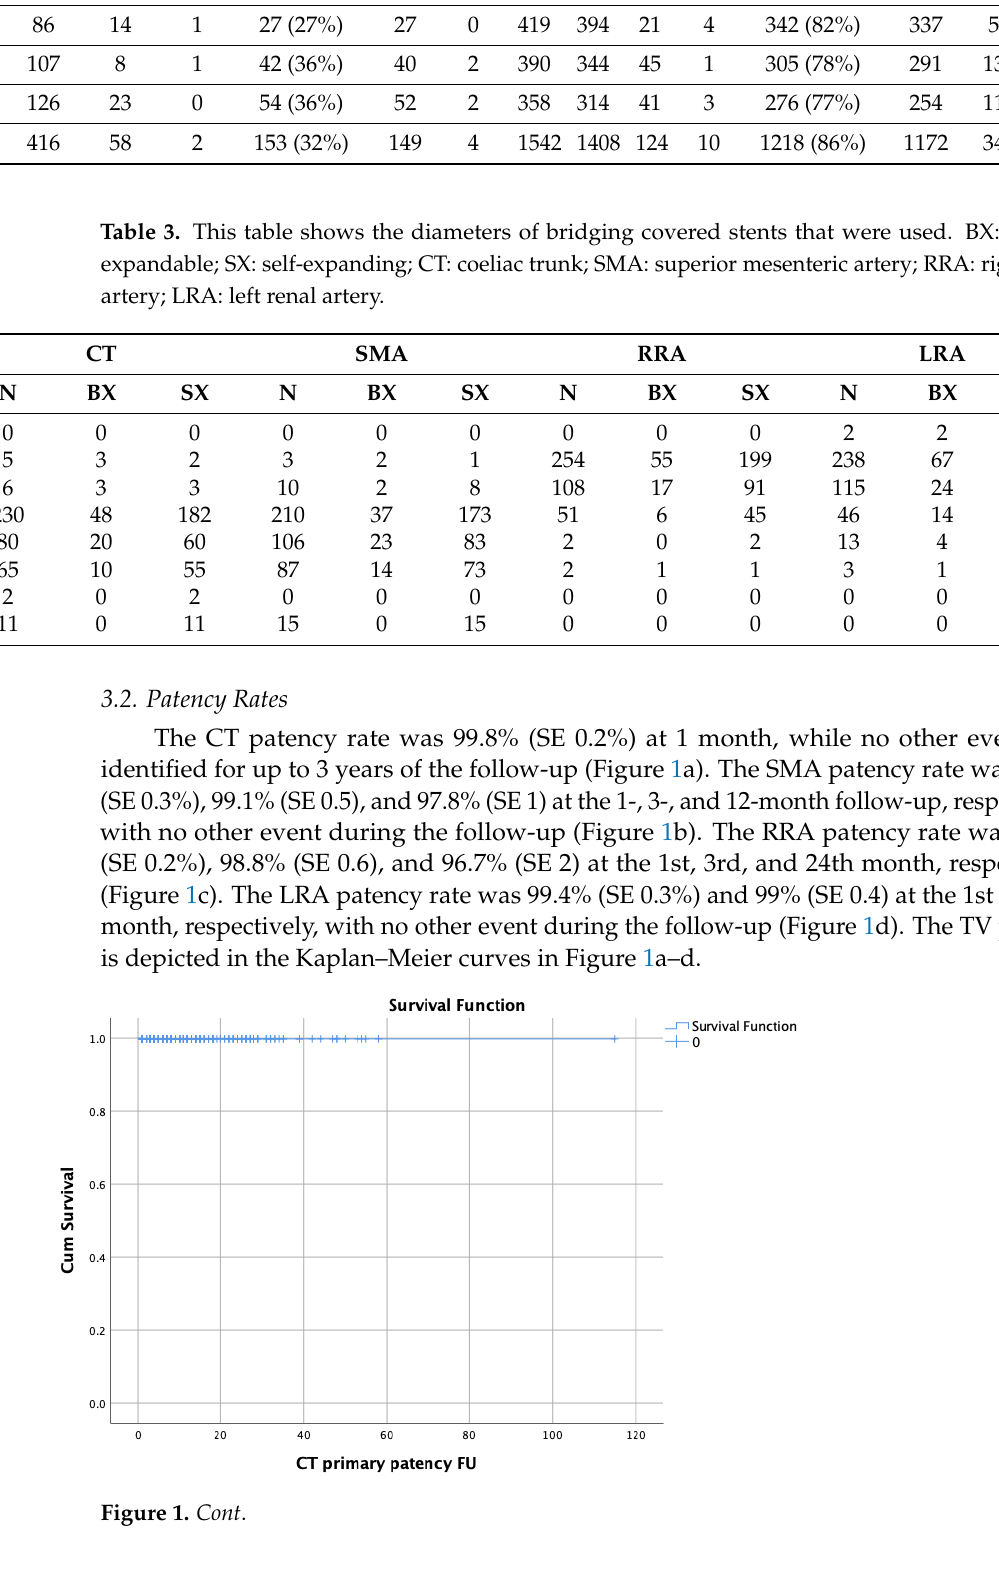
Table 2. This table shows type and number of bridging covered stents that were used for each target vessel. CT: coeliac trunk; SMA: superior mesenteric artery; RRA: right renal artery; LRA: left renal artery; BX: balloon expandable; SX: self-expanding.